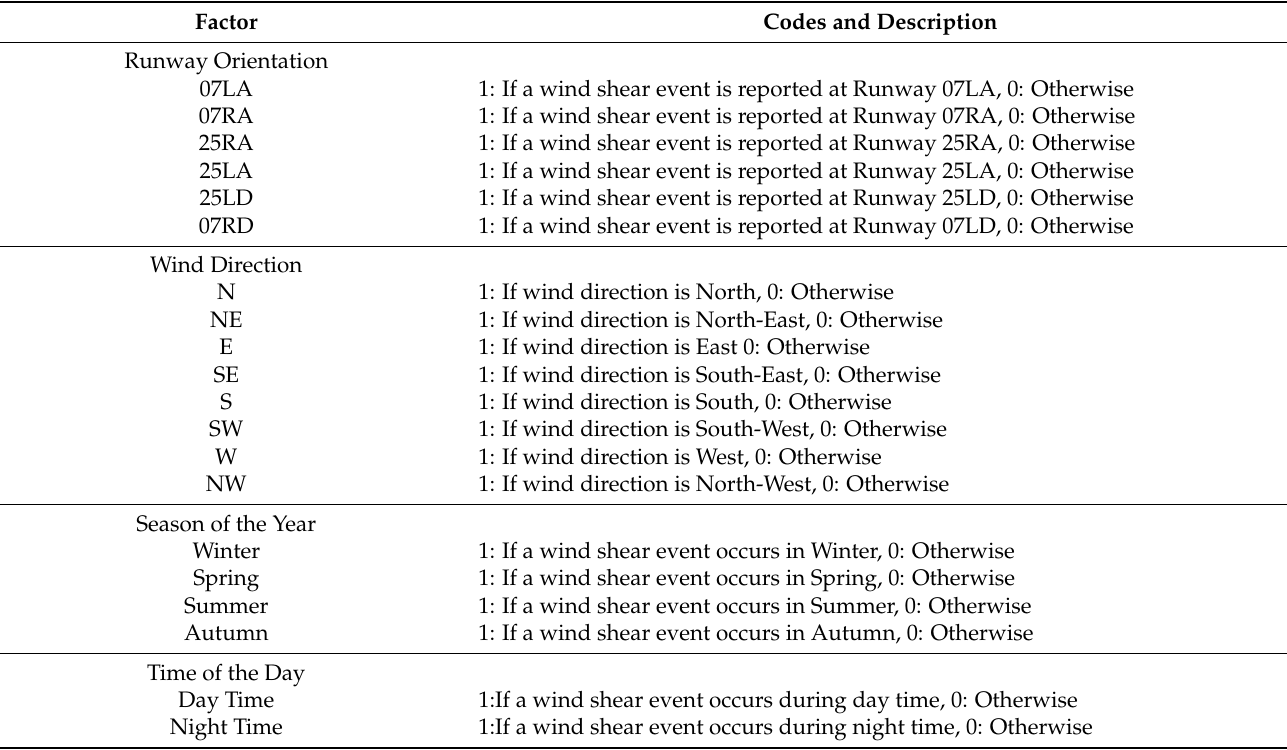
Table 1. One-hot encoding of categorical factors for the modeling.